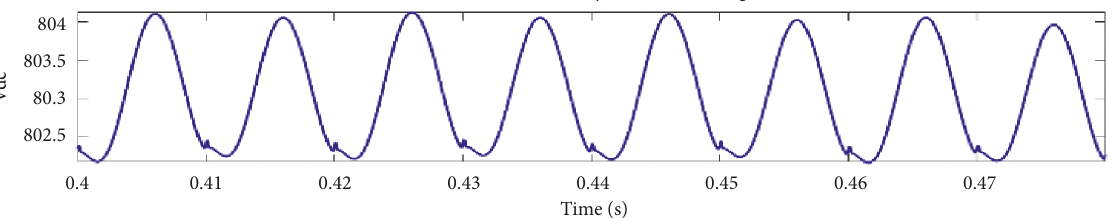
Figure 32: Waveform of the Vdc DC-Bus voltage. FFT window: 10 of 30 cycles